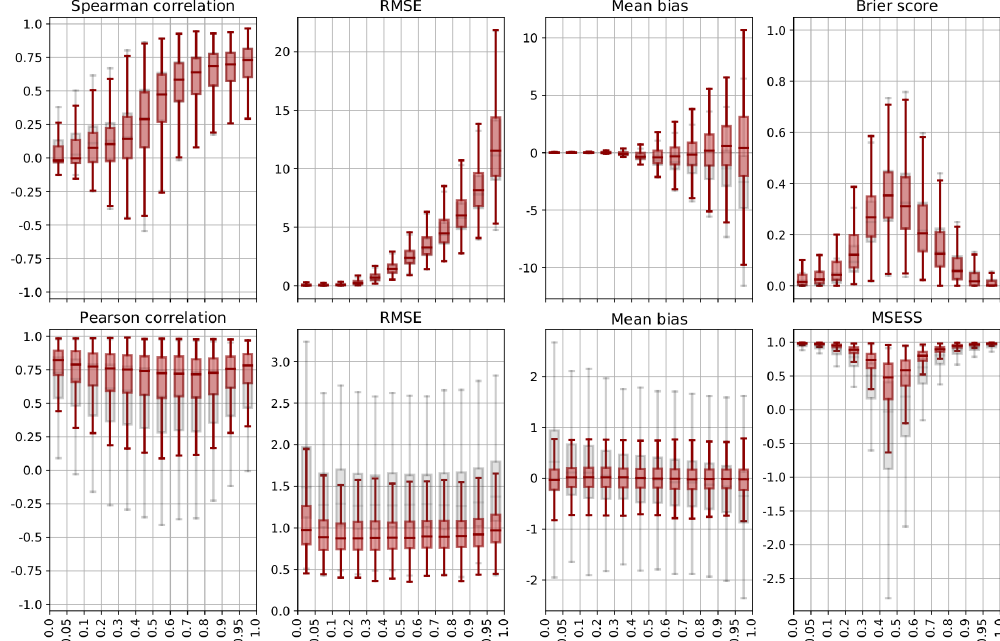
Figure 6. Validation over space of precipitation (top) and temperature (bottom) for ARM reconstructions (grey) and post-processed data (red), separated by quantile groups of spatial average precipitation and temperature, respectively. Shown are the Spearman (precipitation) and Pearson (temperature) correlation, RMSE, bias, Brier score (precipitation), and MSESS (temperature). Boxes range from the first to the third quartile, and whiskers extend to 1.5 times the interquartile range outside the box.